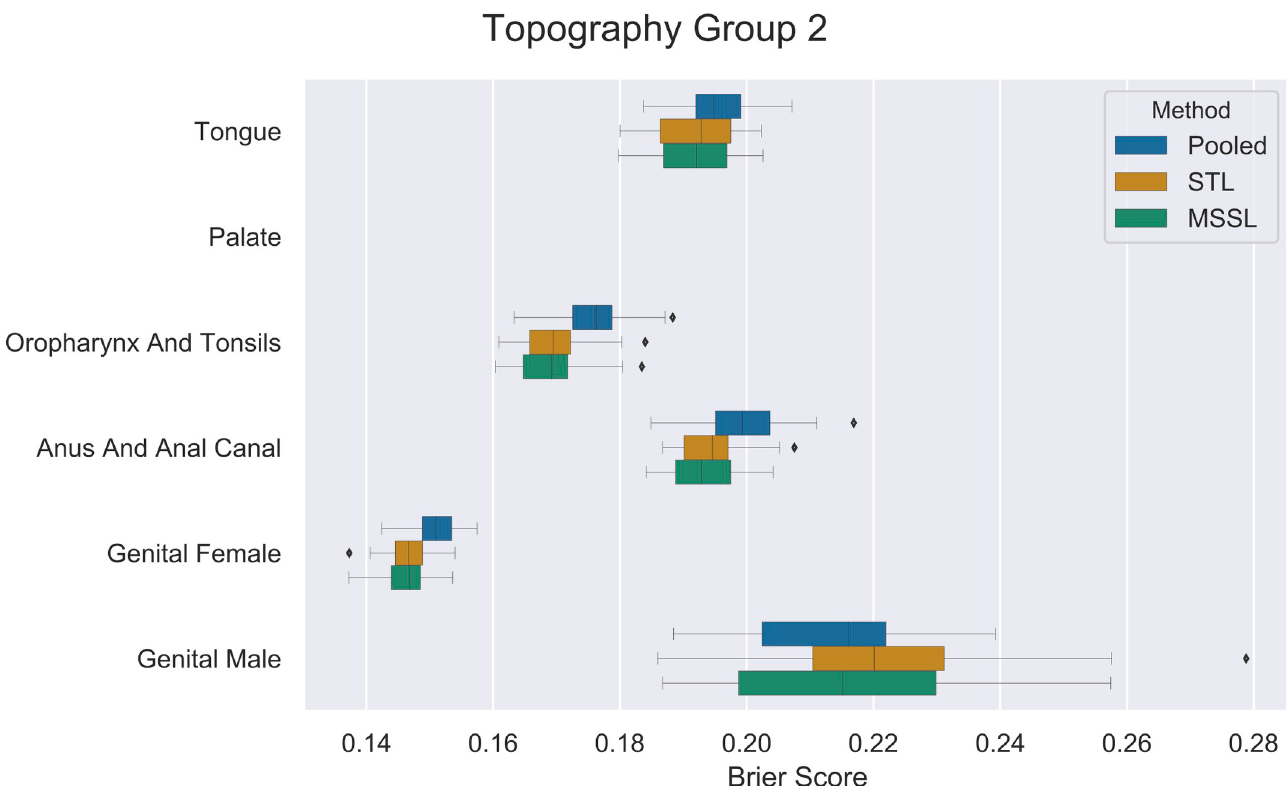
Fig 3. Brier scores (x-axis) for pooled, STL, and MSSL, and pooled classifiers for Topography group 2 data split. Boxplots show results from 30 independent runs.